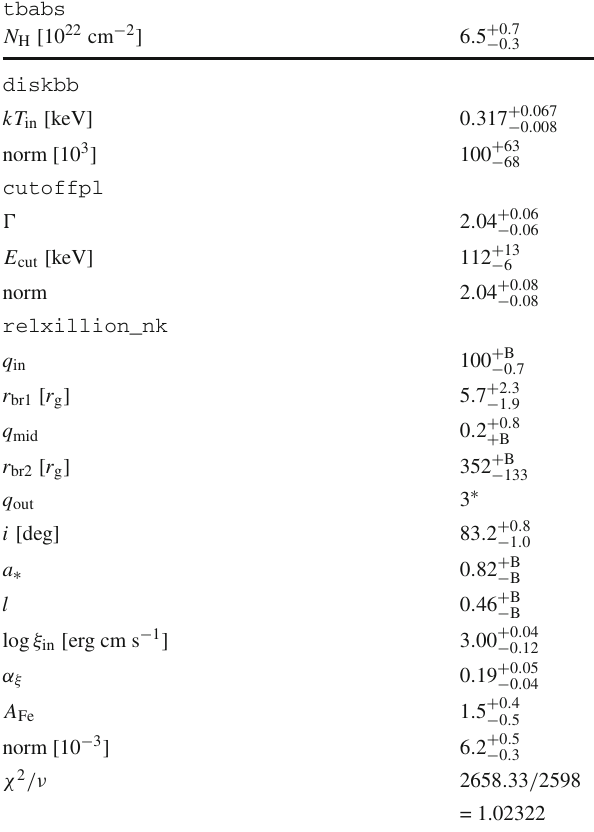
Table 1 The best-fit values from the analysis of the 2019NuSTARdata of EXO 1846-031. The reported uncertainties correspond to the 90% confidence level for one relevant parameter ( (cid:12)χ 2 = 2 . 71). B means that the 90% confidence level limitis not in the parameterrange allowed by the model or the best-fit value is stuck at a boundary of the range allowed by the model: q in and q mid are allowed to vary in the range ( 0 , 10 ) , r ( R , 900 M ) , and a ∗ br2 is allowed to vary in the range ISCO